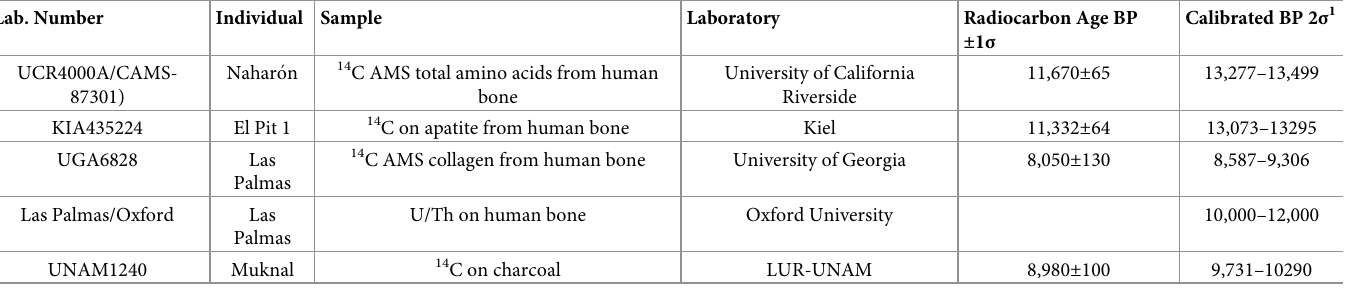
Table 1. Radiometric dates of human bone and charcoal associated with the skeletons from submerged caves in the Tulum area, Quintana Roo, Mexico. Lab.